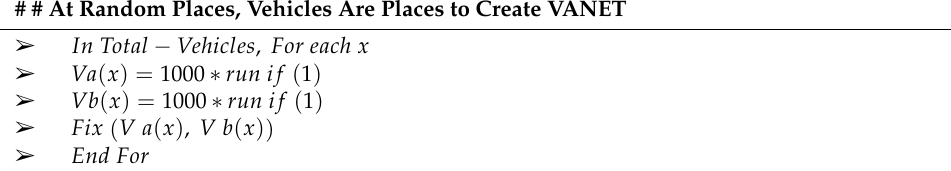
Table 1. Vehicle placement in the VANET.